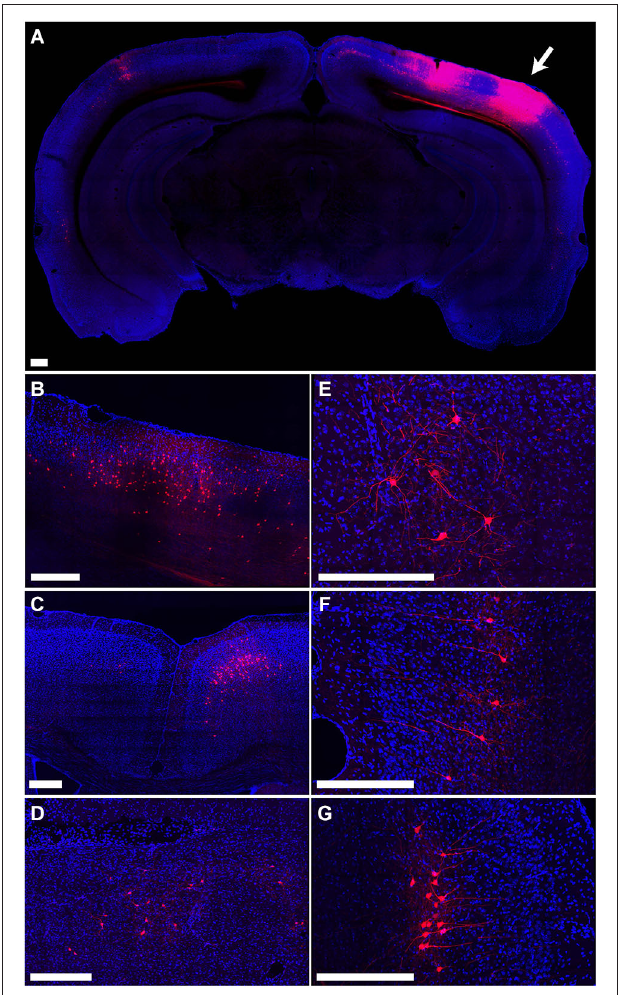
FIGURE 4 | Retrograde labeling by PRV IE180-null-hSyn-Cre in secondary visual cortex. (A) Fluorescence image showing the distribution of tdTomato labeling in an Ai14 mouse injected with PRV-hSyn-Cre in the secondary visual cortex. Arrow points to site of injection. (B–G) Retrograde labeling by PRV-hSyn-Cre in (B) primary visual cortex ipsilateral to the site of injection, (C) anterior cingulate cortex, (D) lateral posterior nucleus of the thalamus, (E) ipsilateral amygdala, (F) contralateral perirhinal cortex, (G) ipsilateral perirhinal cortex. Scale bars—300 um.